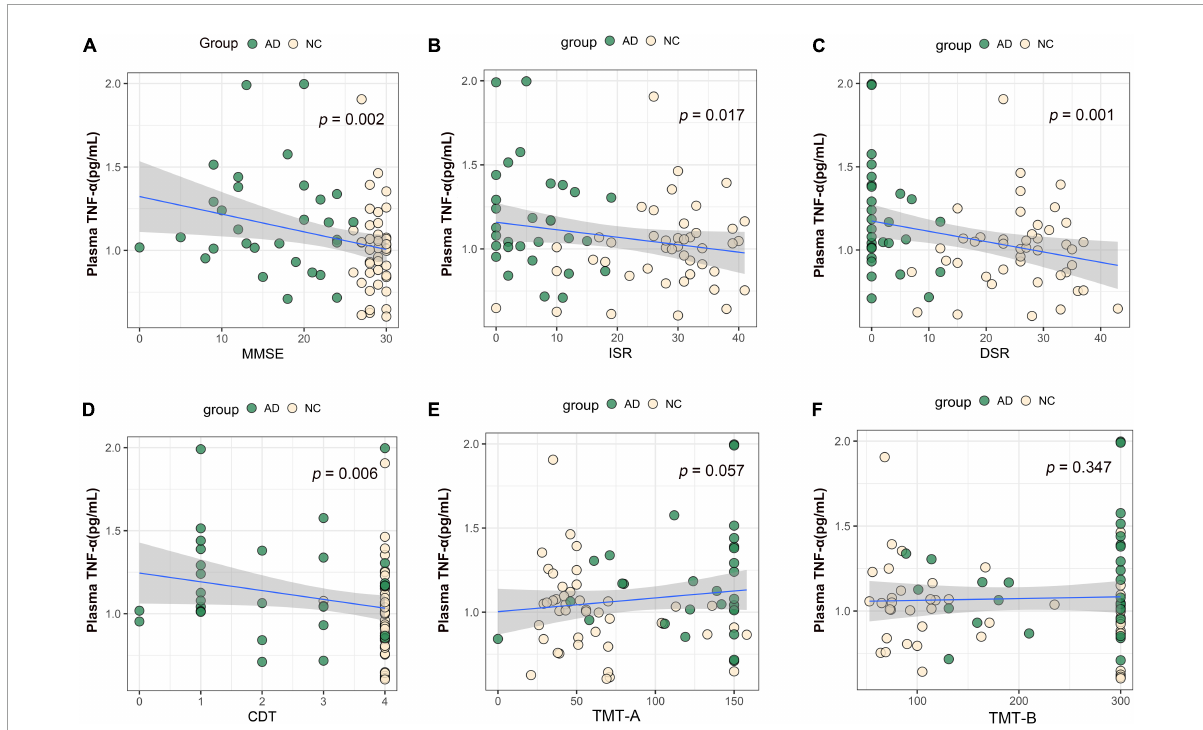
FIGURE5 Association between plasma TNF- α and cognitive domains. (A) Association between plasma TNF- α and MMSE. (B) Association between plasma TNF- α and ISR. (C) Association between plasma TNF- α and DSR. (D) Association between plasma TNF- α and CDT. (E) Association between plasma TNF- α and TMT-A. (F) Association between plasma TNF- α and TMT-B. Multiple regression analysis was used and adjusted for years of education. AD, Alzheimer’s diseases; NC, normal control; MMSE, Mini-Mental Status Examination; ADL, Activity of Daily Living; ISR, Immediate story recall; DSR, delayed Story Recall Scale; CDT, clock drawing test; TMT-A, trail making test A; TMT-B, trail making test B; pg/ml,